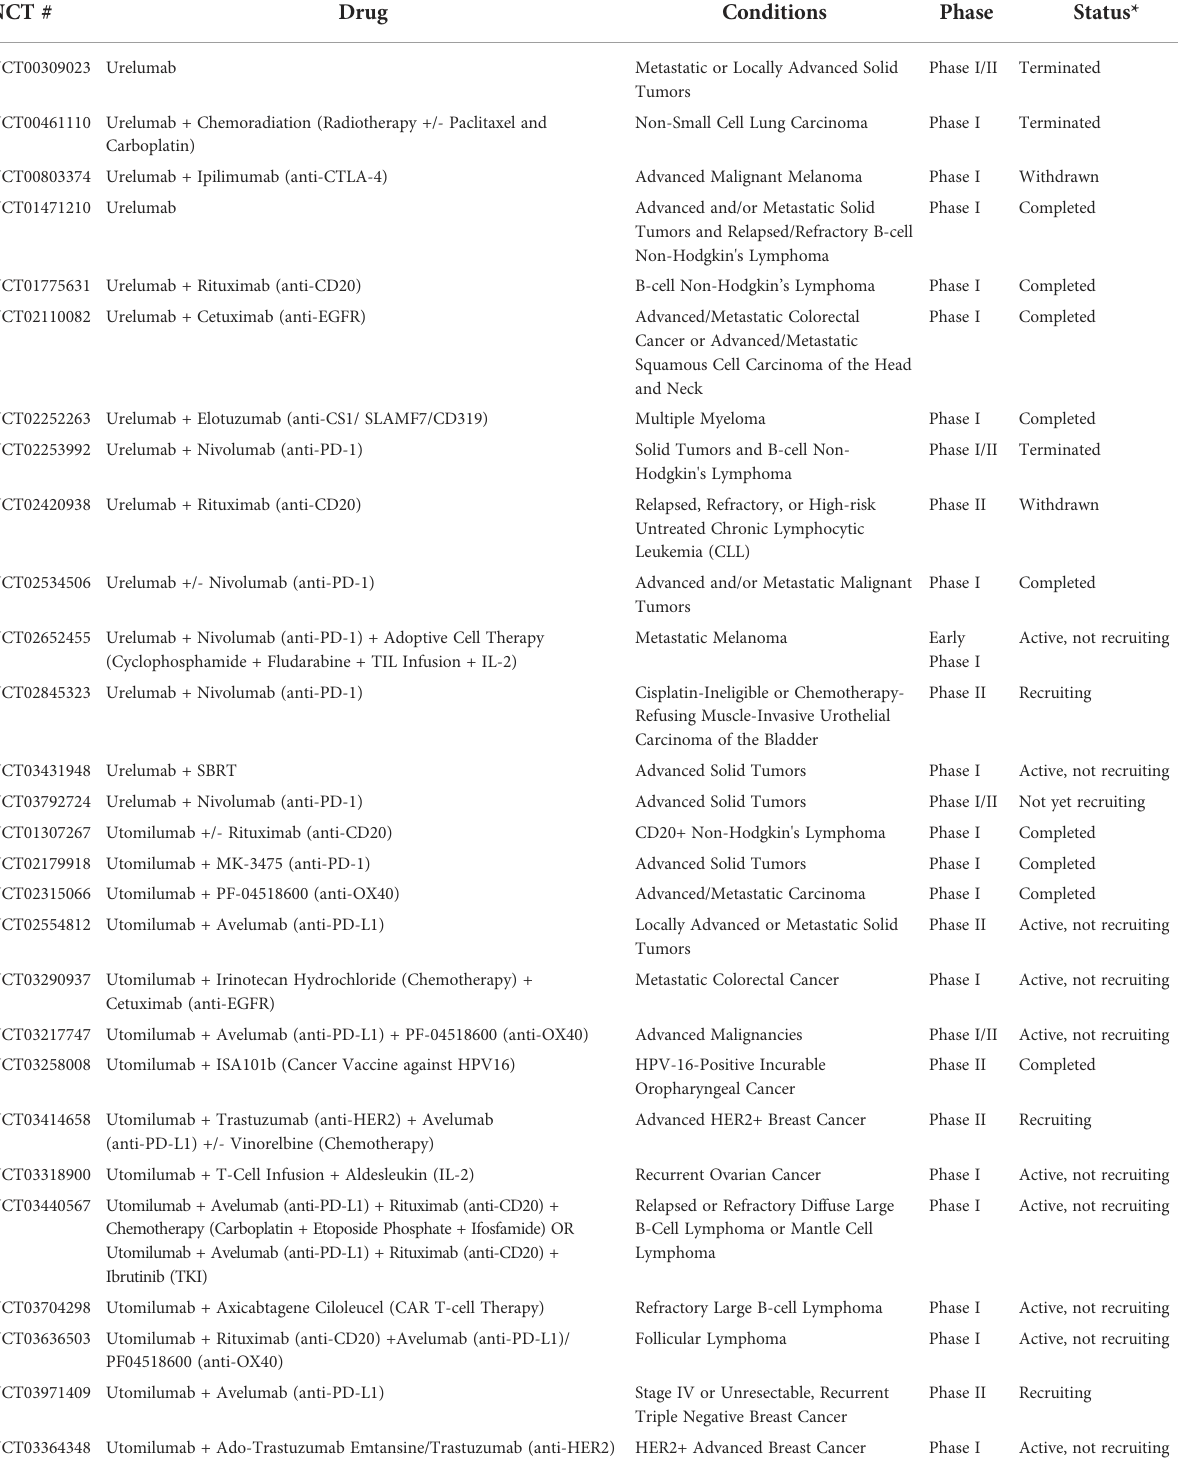
TABLE 1 Summary of clinical trials involving urelumab or utomilumab alone or in combination with other anti-tumoral